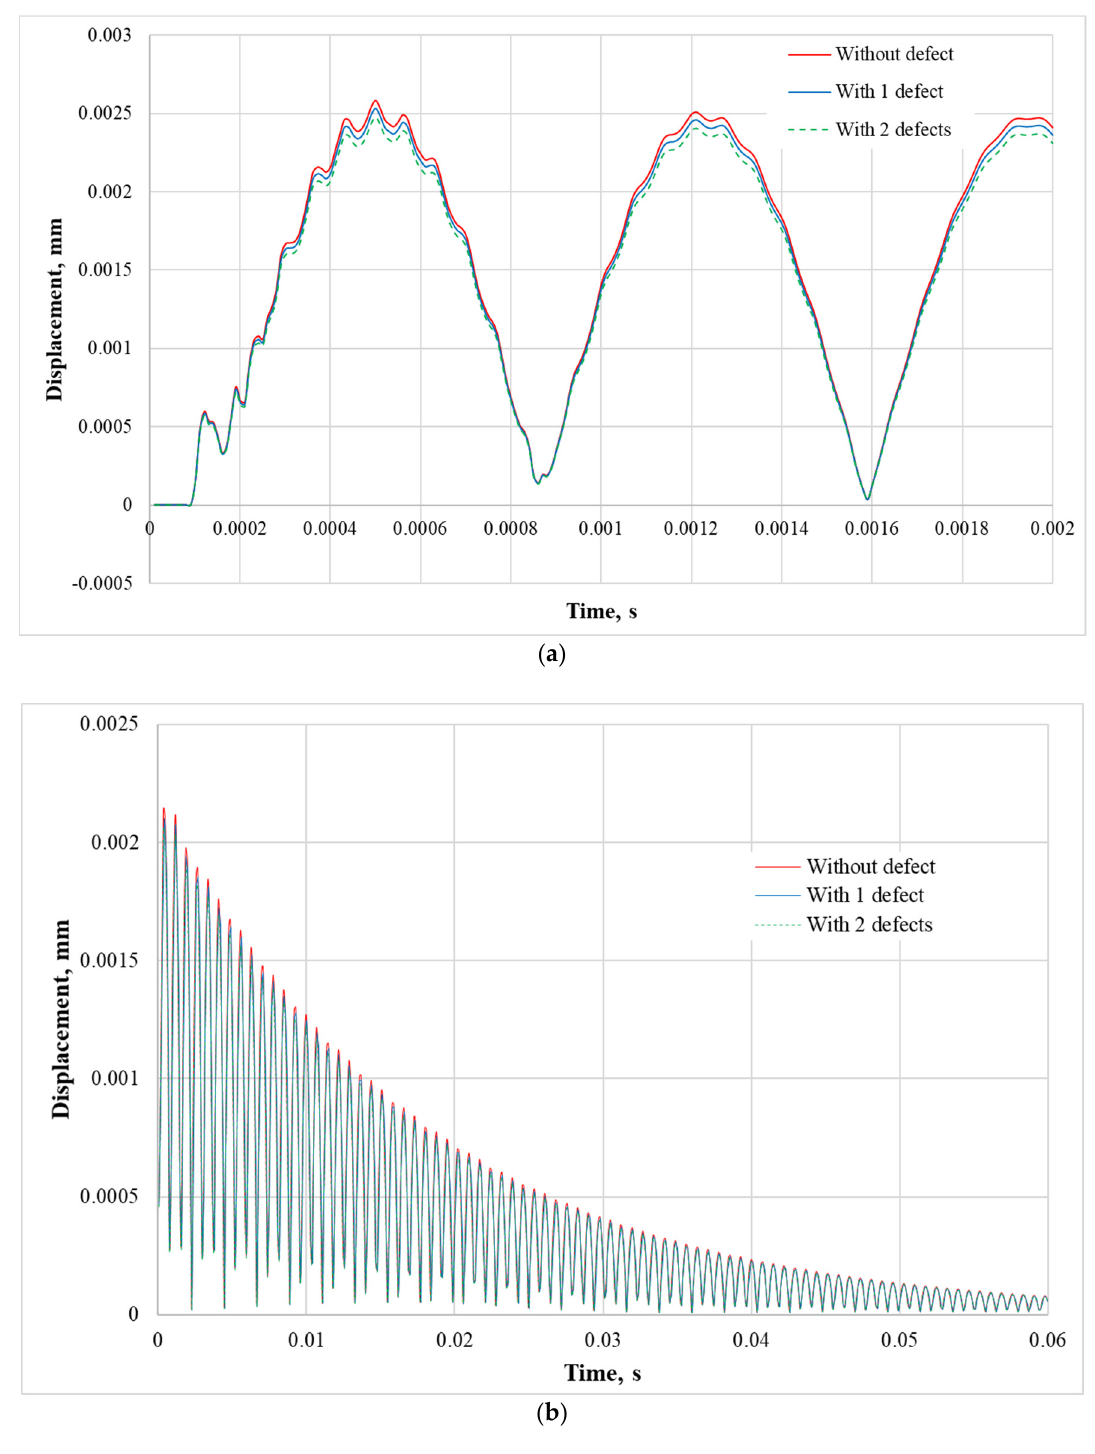
Figure 5. Displacement response of the composite plate displacement response (of nodal point no. 118498) which consists of 119280 nodal points to the impact force; red, blue and green curves present the composite plate without defect, with one defect and with two defects, respectively: ( a ) Simulation time of 0.002 s; ( b ) Simulation time of 0.06